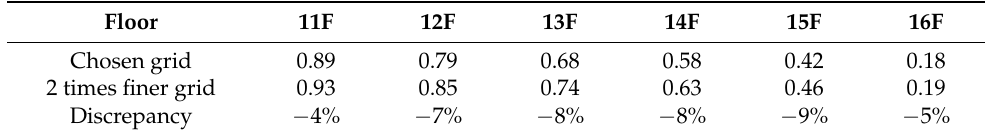
Table 6. Velocity for various grid arrangements (m/s).